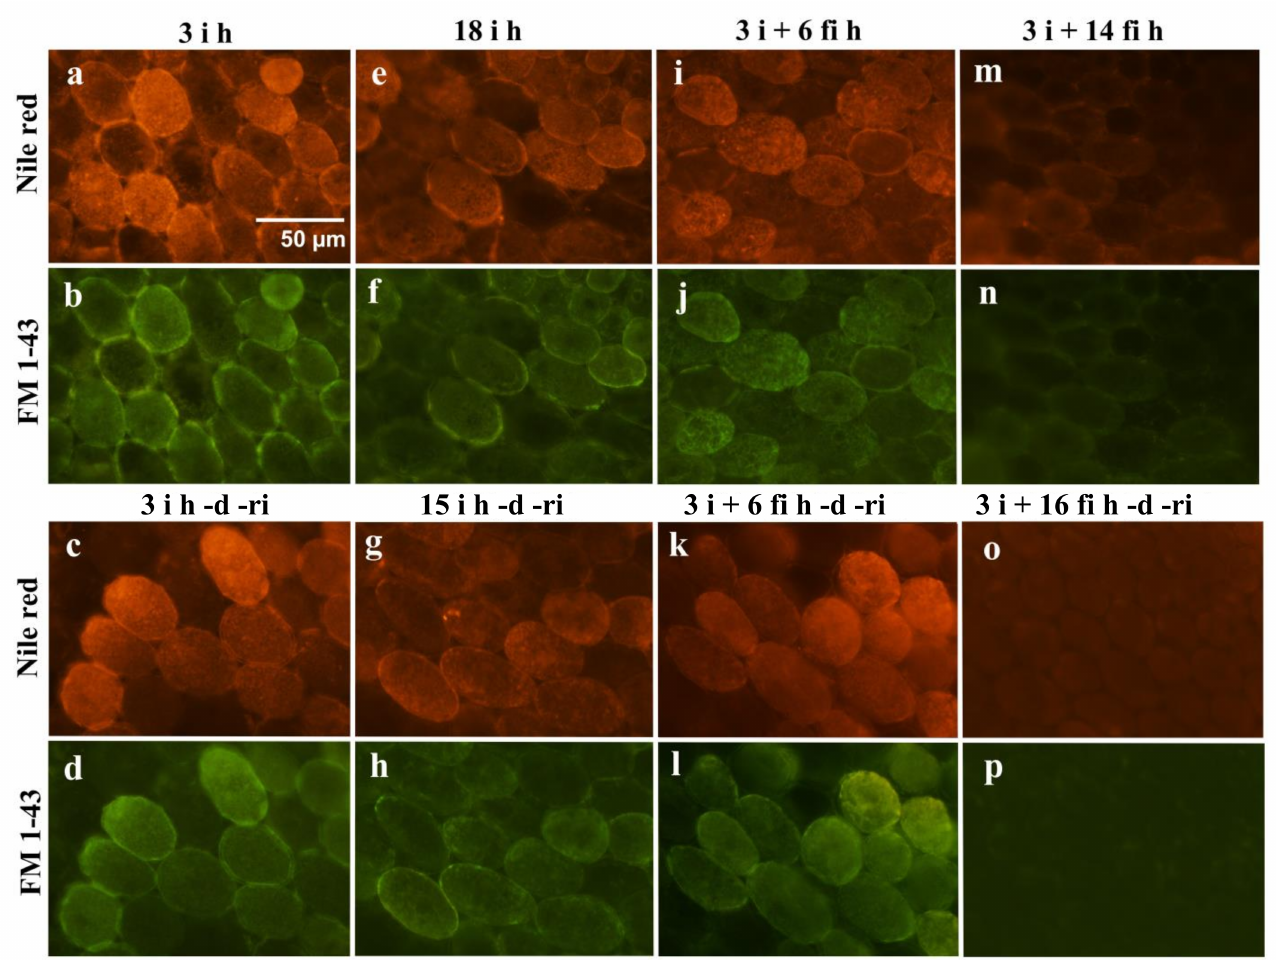
Figure 5. Observation of lipid droplets along the plasma membrane of radicle cells. Lipid droplets and plasma membranes were fluorescently stained with Nile red ( a , c , e , g , i , k , m , o ) and FM 1-43 ( b , d , f , h , j , l , n , p ). The staining patterns of Nile red (intense fluorescence primarily indicating lipid droplets) was only subtly different from the pattern exhibited by the membrane stain FM 1-43 in radicle cells after 3 h imbibition (3 i h: ( a , b )) and after re-imbibition following 3 h imbibition and desiccation (3 i h - d - ri : ( c , d )). Intense Nile red staining along the plasma membrane was also observed in radicle cells after 18 h imbibition (18 i h: ( e , f )) and in the embryonic axes kept for 6 h on wet filter paper after excision (3 i + 6 fi h: ( i , j )). The intense staining remained to some extent after desiccation and re-imbibition of equivalent samples (15 i h - d - ri : ( g , h ); 3 i + 6 fi h - d - ri : ( k , l )). The Nile red staining along the plasma membrane of the radicle cells was reduced significantly in embryonic axes kept on wet filter paper longer than 12 h after excision (3 i + 14 fi h: ( m , n )), and Nile red staining in those cells was negligible (3 i + 16 fi h - d - ri : ( o , p )) after desiccation and re-imbibition. The percentage of the length of the intense Nile red stained portion at the plasma membrane was measured and compared (Figure 6). The length of intense Nile red staining indicating lipid droplet accumulation was reduced significantly in the fi samples when they were kept on the wet filter paper for 12 h and 16